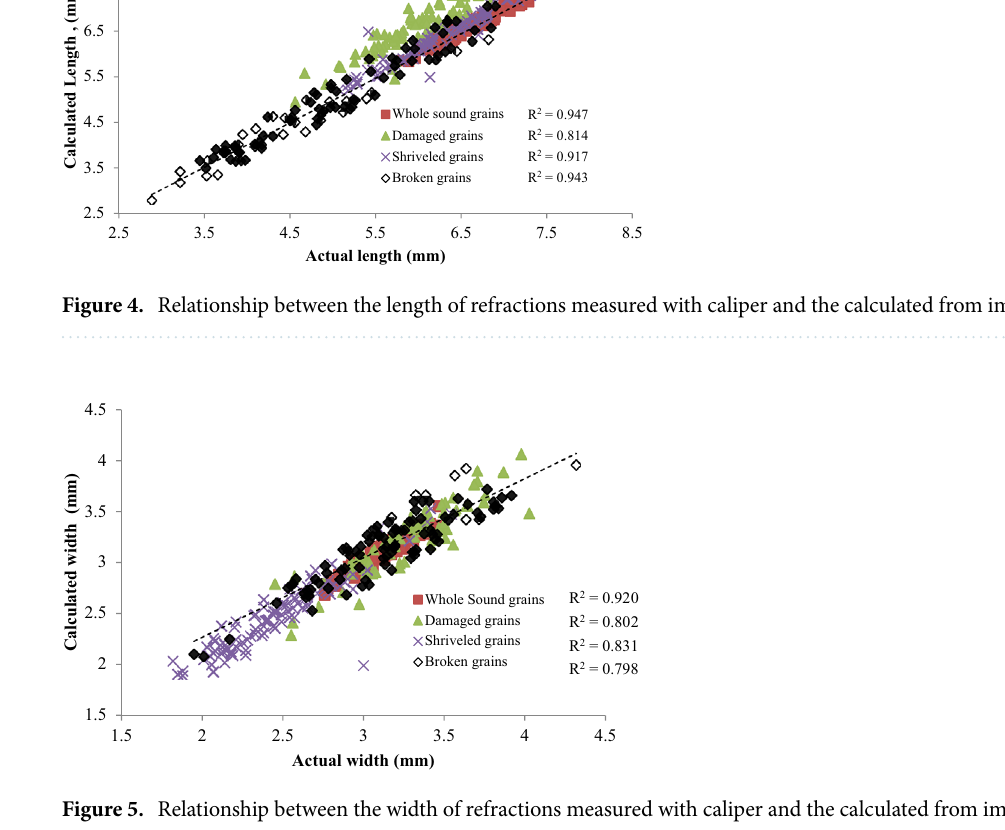
Figure 5. Relationship between the width of refractions measured with caliper and the calculated from